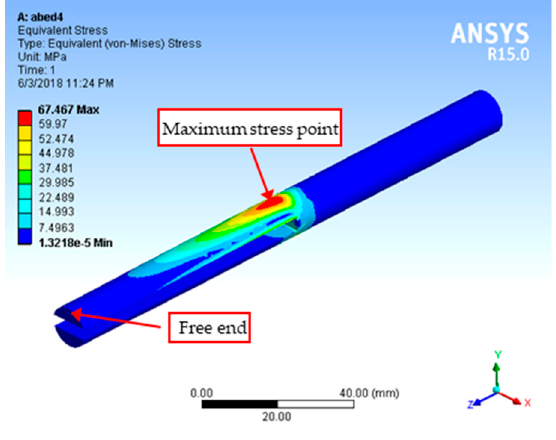
Figure 4. Stress analysis of the pincer object where an external force is applied at the free end.